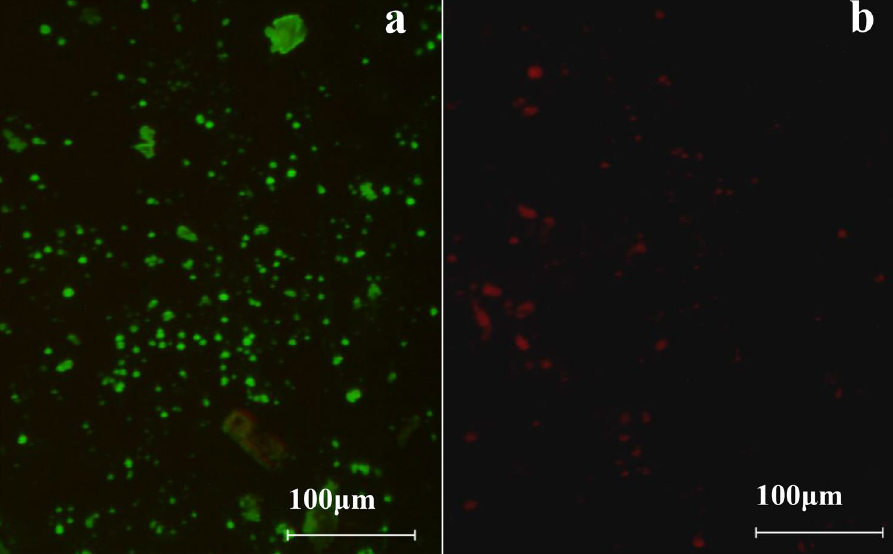
Figure 3. Fluorescence microscopy images of E. coli (× 100). Fluorescence microscopy image of live/dead bacteria on cucumber slices inoculated with E. coli after 30 min ( a ) and 2 h ( b ) from inoculation. Image-Pro plus 6.0.0 (https:// www. xrays can. com/ softw are- image- pro- plus/, https:// www. xrays can.